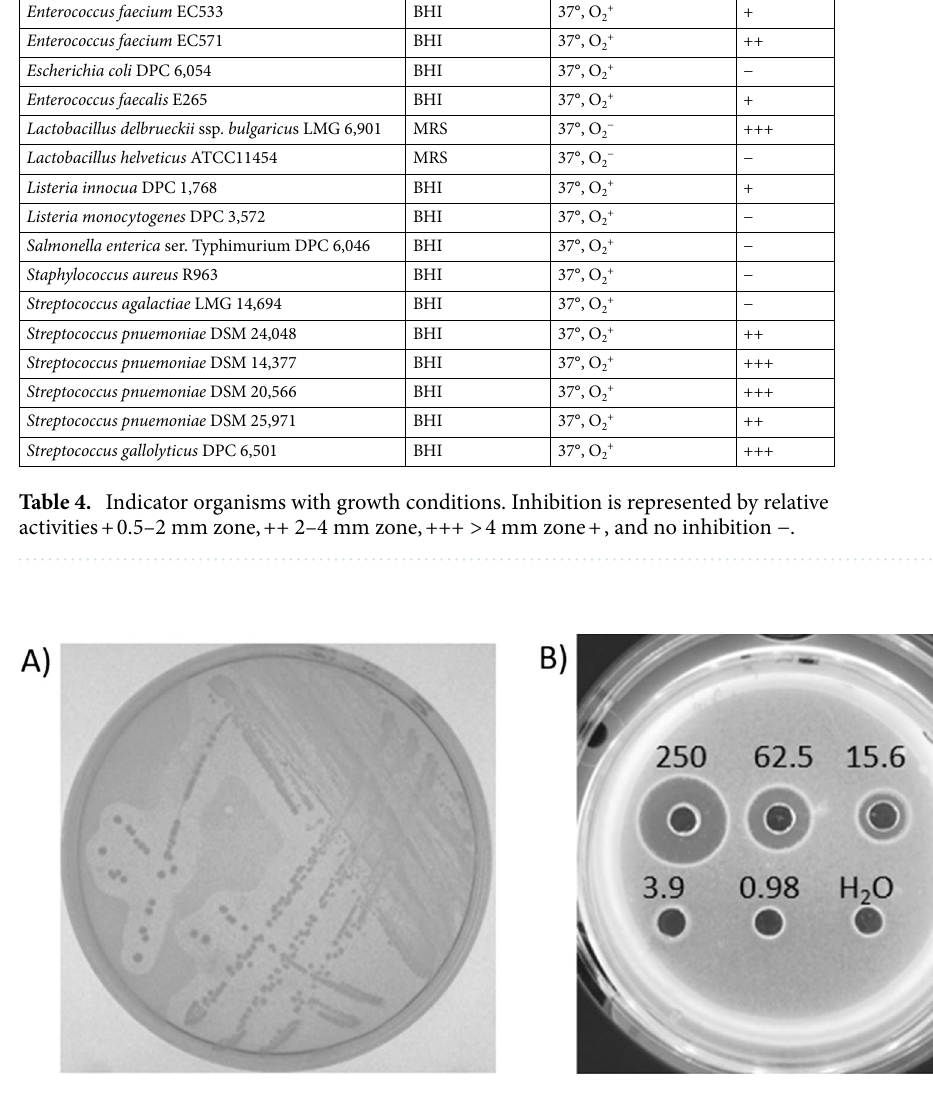
Figure 5. ( A ) Sgg LL009 colonies showing inhibition of Sgg DPC6501 (indicator organism). ( B ) Well diffusion assay using synthesized gallocin D against Sgg DPC6501, concentration in µM indicated above each